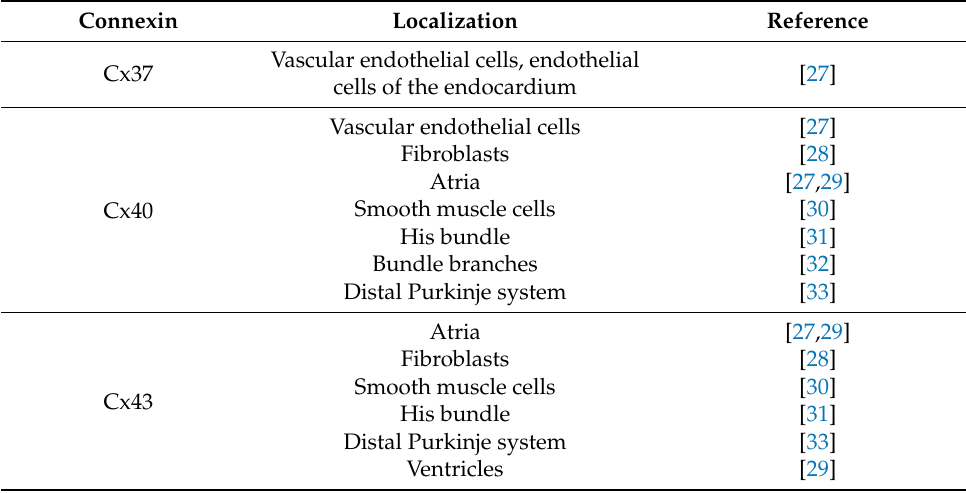
Table 1. Localization of connexins in the